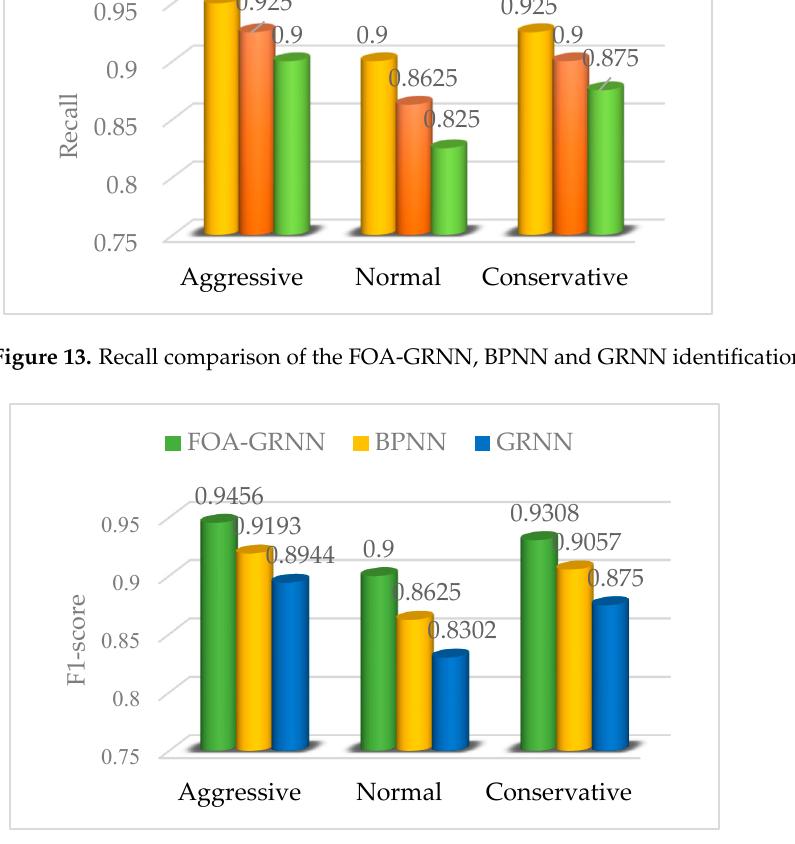
Figure 14. F1 score comparison of the FOA-GRNN, BPNN and GRNN identification models.